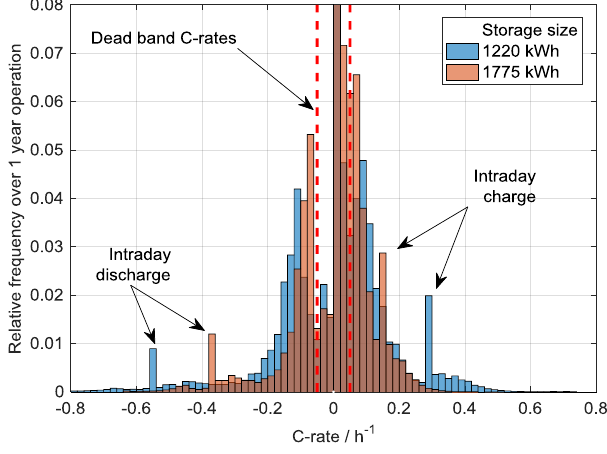
Figure 10. Relative frequency of the C rate.